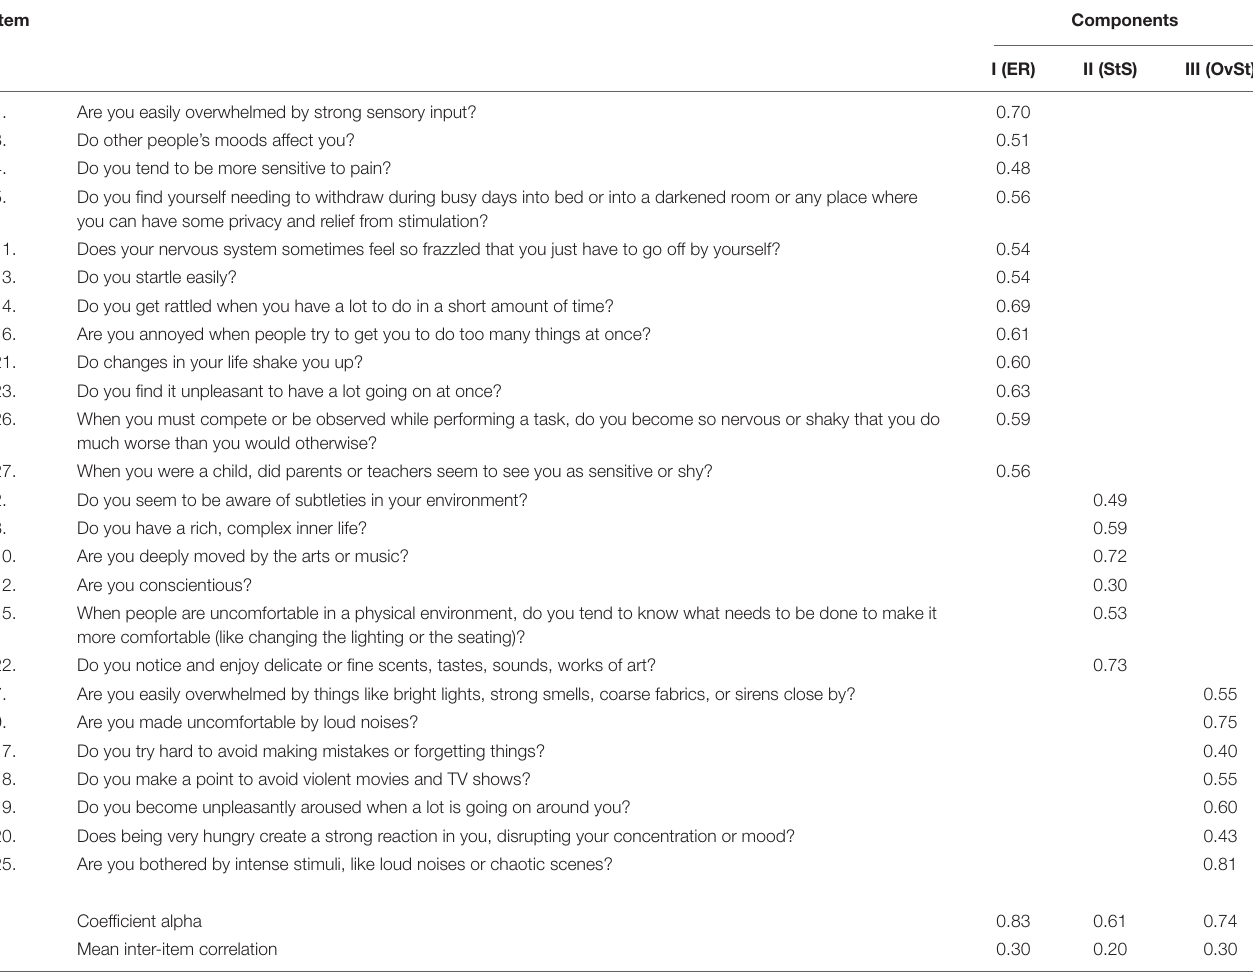
TABLE 1 | Principal components analysis with oblimin rotation: Component loadings, alphas, and mean inter-item correlations for the HSPS (three-factor analysis).